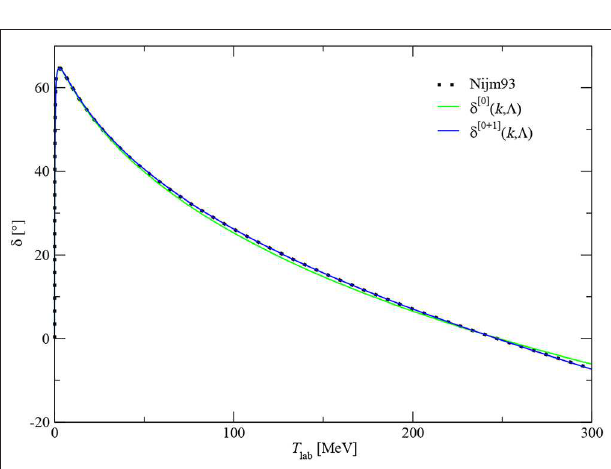
FIGURE 8 | Two-nucleon 1 S 0 phase shift δ as function of the laboratory energy T lab in an expansion that incorporates the amplitude zero at LO. The LO (green) and NLO (blue) bands correspond to cutoff variation from 0.6 to 2 GeV. The results from the Nijm93 potential [119] (black squares) are shown for comparison. Reprinted figure with permission from reference [117]. Copyright (2018) by the American Physical